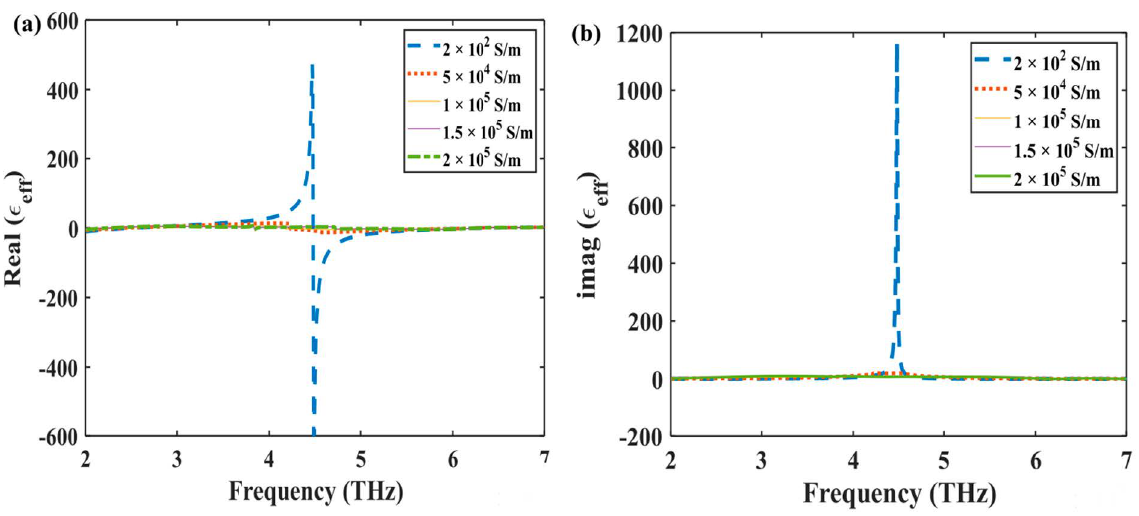
Figure 5. ( a ) The real part of the effective permittivity and ( b ) imaginary parts of effective permittivity for varying VO 2 conductivities.